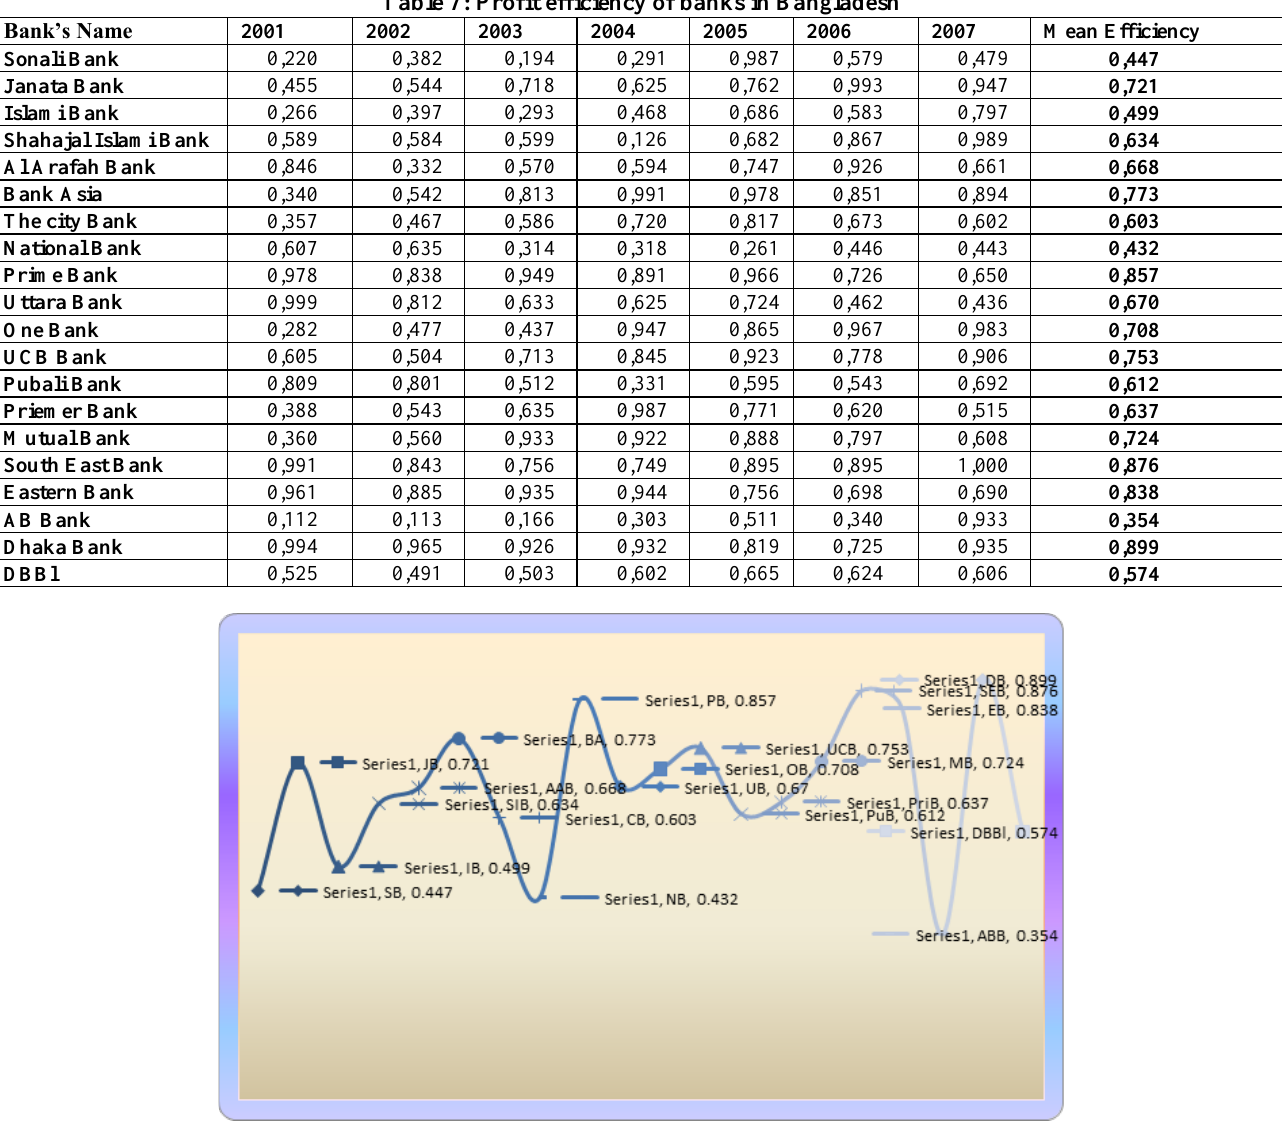
Table 7: Profit efficiency of banks in Bangladesh